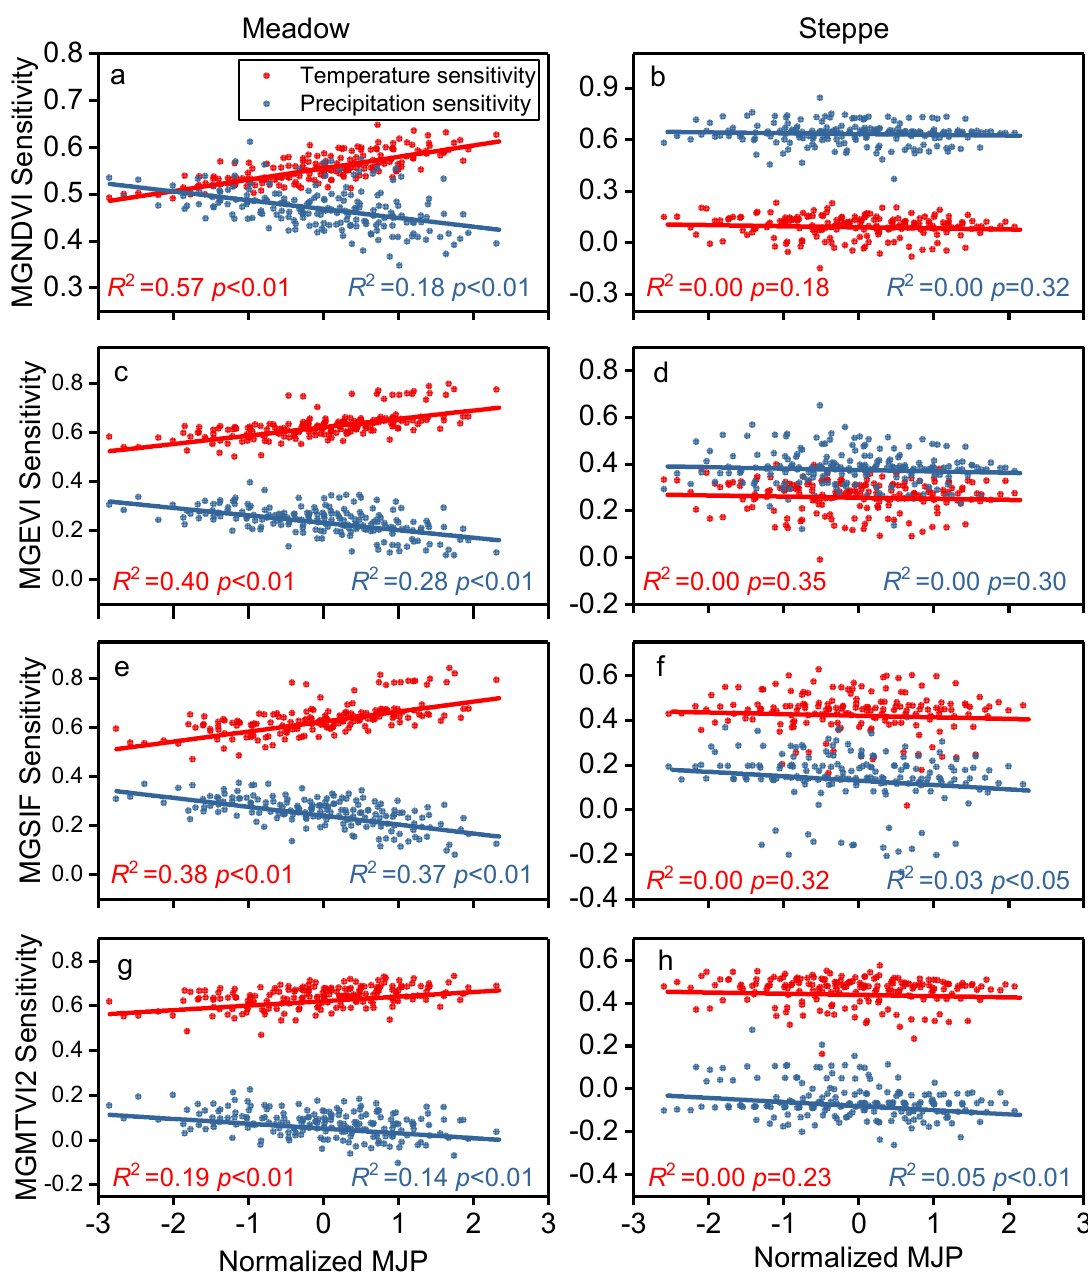
Figure 6. Response of temperature and precipitation sensitivity of the MGNDVI ( a , b ), MGEVI ( c , d ), MGSIF ( e , f ), and MGMTVI2 ( g , h ) to MJP change on the meadow and the steppe on the TP. The red and blue points show the temperature sensitivity and precipitation sensitivity, and the red and blue lines indicate the linear trends of the climate sensitivity as MJP changes. The R 2 is the coefficient of determination and p reveals the significance level.